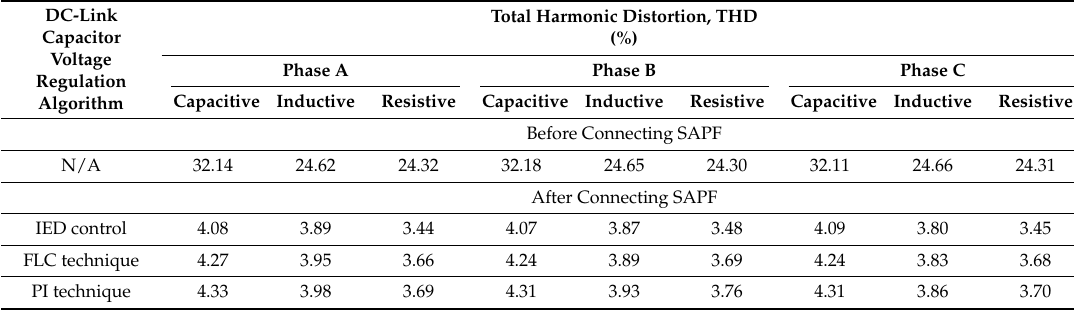
Table 7. THD values of source current i S in all phases resulted from SAPF utilizing each DC-link capacitor voltage regulation algorithm (experimental